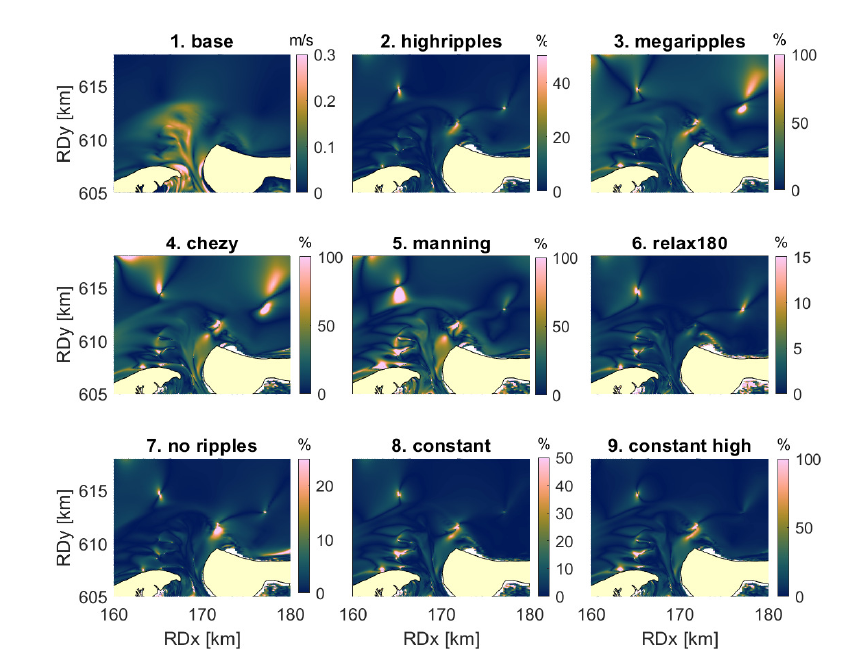
Figure 8. Mean depth-averaged current velocity u c (m/s) of the base scenario during calm weather (1), and mean absolute relative difference in u c of all other scenarios with the base scenario during calm weather (2–9).